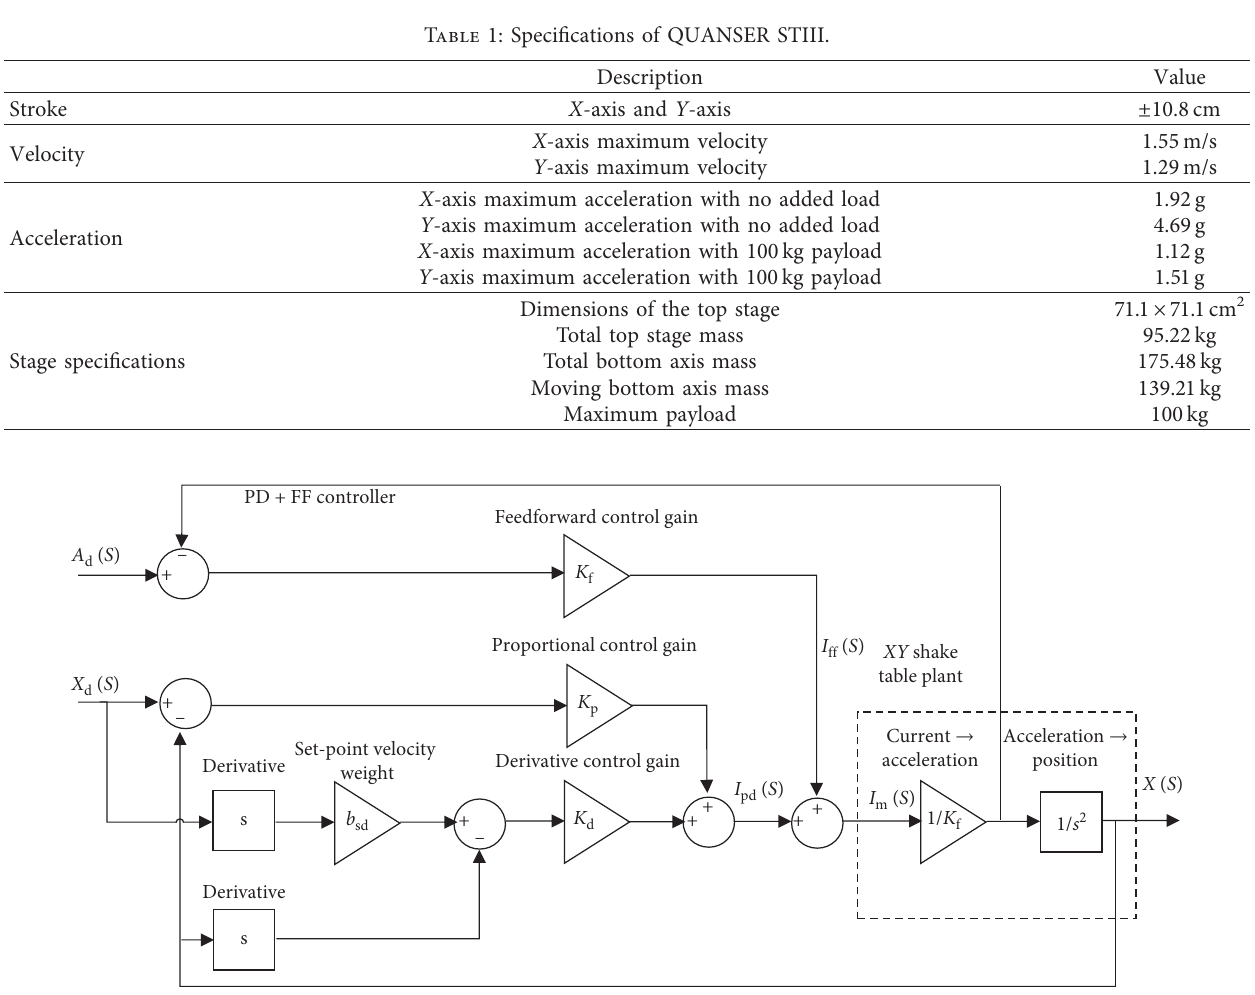
table plant Current →